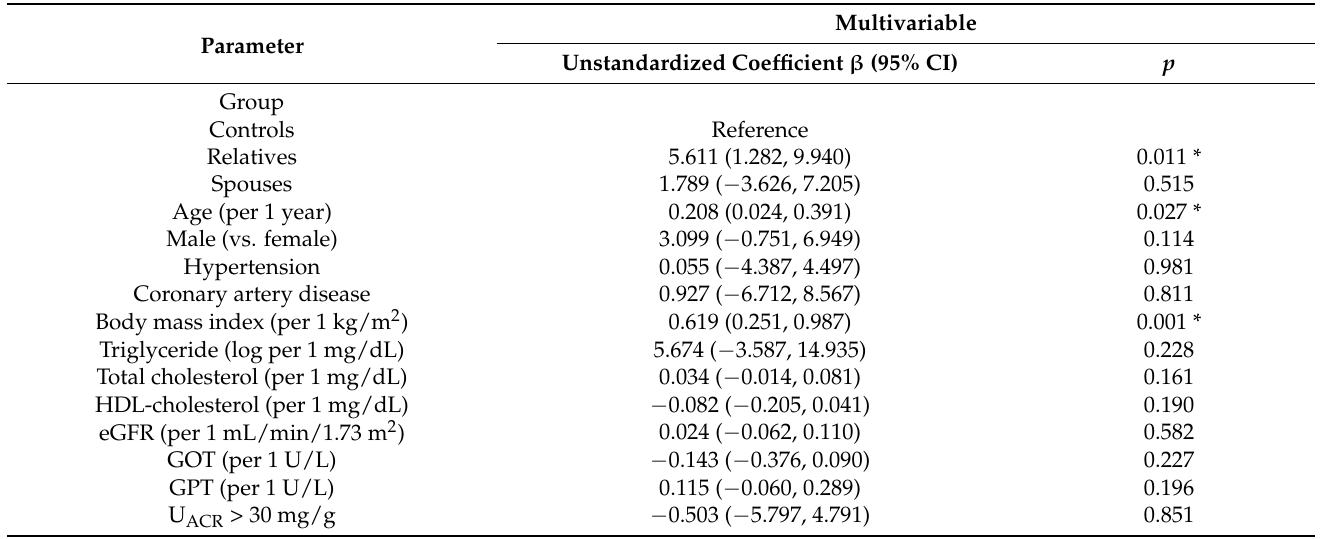
Table 2. Determinants of fasting glucose using multivariable linear regression analysis.